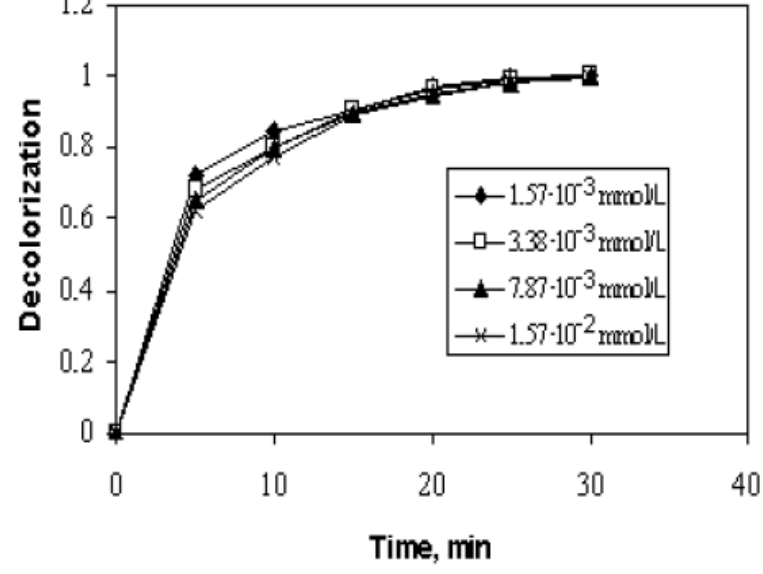
Fig. 10 Effect of Cu 2+ ions on AOP in acidic medium. Initial conditions: C dye =50 mg/L, [H 2 O 2 ]= 17.318